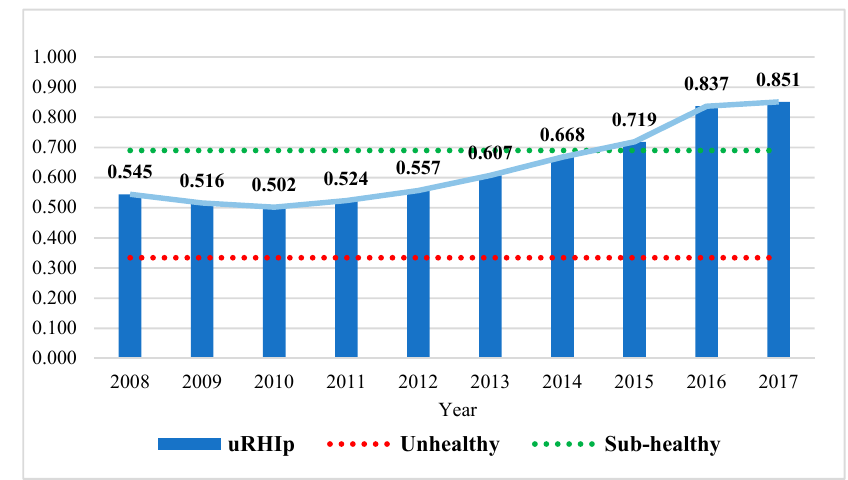
Figure 4. Jialu River uRHI P trend from 2008 to 2017.